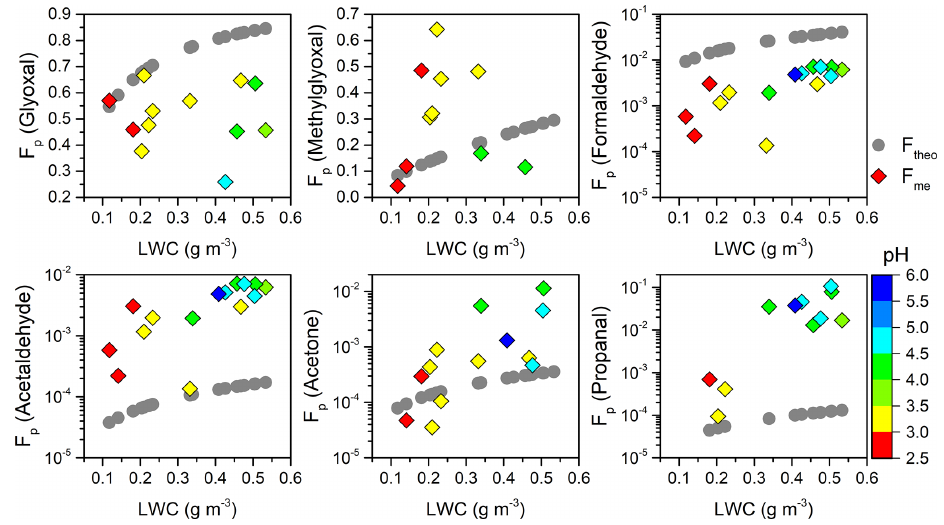
Figure 5. Theoretical ( F theo ; gray circle) and measured ( F me ; colored diamond) aqueous-phase fraction ( F p ) of carbonyl compounds as a function of LWC and